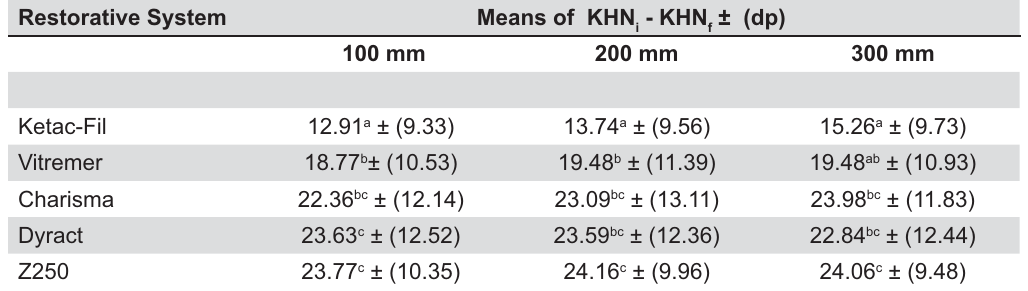
Statistical differences are expressed by different superscript letters (p< 0.05) Table 2- (cid:6)(cid:25)(cid:7)(cid:9)(cid:19)(cid:1)(cid:6)(cid:15)(cid:16)(cid:6)(cid:2)(cid:11)(cid:7)(cid:6)(cid:4)(cid:14)(cid:16)(cid:16)(cid:7)(cid:13)(cid:7)(cid:19)(cid:12)(cid:7)(cid:1)(cid:6)(cid:30)(cid:7)(cid:2)(cid:22)(cid:7)(cid:7)(cid:19)(cid:6)(cid:14)(cid:19)(cid:14)(cid:2)(cid:14)(cid:9)(cid:10)(cid:6)(cid:9)(cid:19)(cid:4)(cid:6)!(cid:19)(cid:9)(cid:10)(cid:6)(cid:4)(cid:7)(cid:19)(cid:2)(cid:14)(cid:19)(cid:6)(cid:21)(cid:14)(cid:12)(cid:13)(cid:15)(cid:11)(cid:9)(cid:13)(cid:4)(cid:19)(cid:7)(cid:1)(cid:1)(cid:6)$"(cid:130)(cid:131) evaluated at distances of 100, 200 and 300